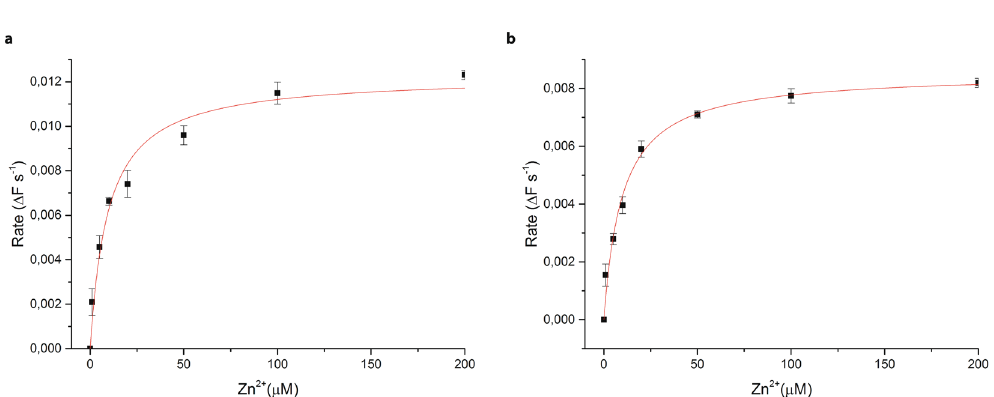
Figure 7. Rate of transport dependence on Zn 2 + concentration in ( a ) TmCorA (b) MjCorA. The solid lines represent the fit to the Michaelis–Menten equation (based on FluoZin-1 experiments). Error bars represent s.e.m. from three or more technical replicates of independent